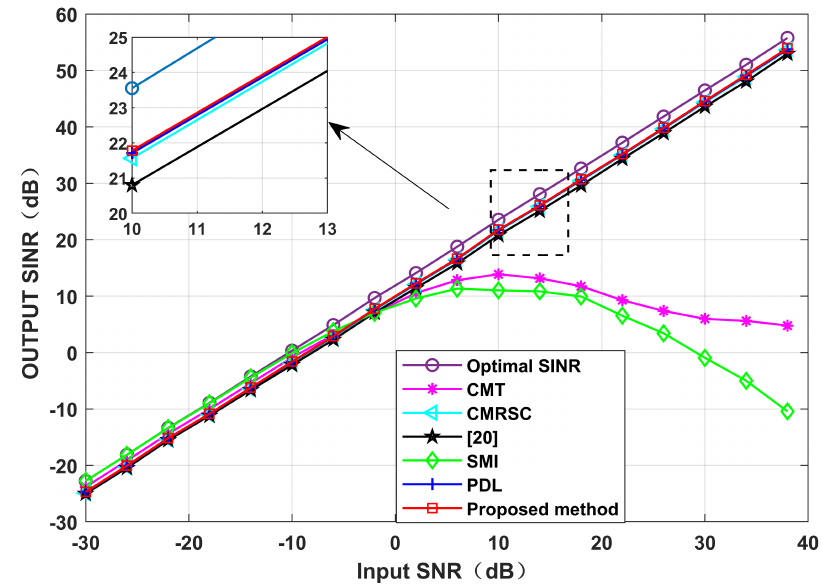
Figure 17. Output SINR versus input SNR in the case of array geometry errors. Simulation